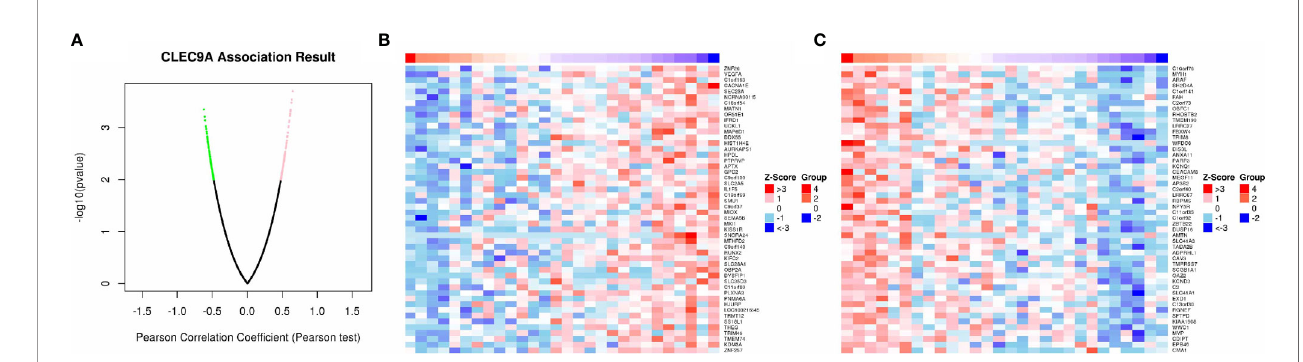
FIGURE 6 | Co-expression genes in correlation with CLEC9A in LUAD. (A) A Pearson test was used to analyze correlations between CLEC9A and co-expression genes in LUAD. (B, C) Heat maps showing genes positively and negatively correlated with CLEC9A in LUAD. Red indicates positively correlated genes and green indicates negatively correlated genes.